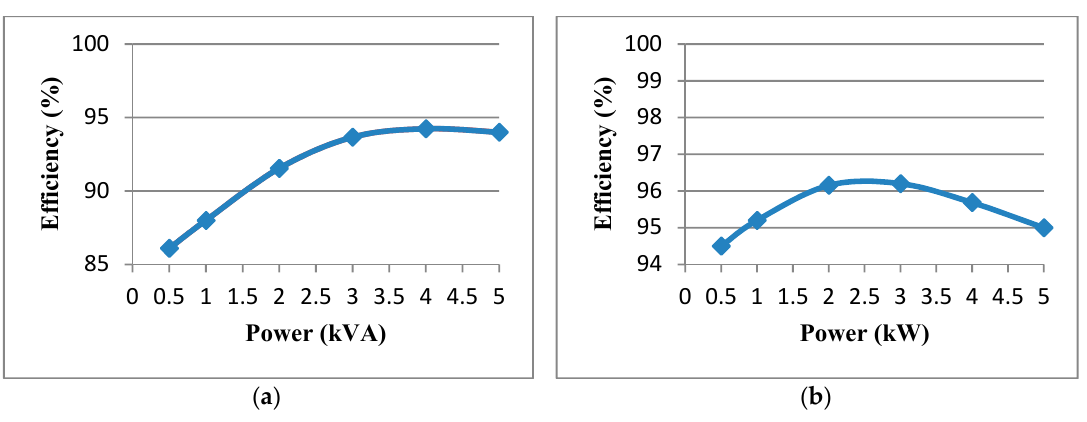
Figure 38. The efficiency analysis of the PCS: ( a ) grid-tied inverter, ( b ) interleaved buck-boost converter.